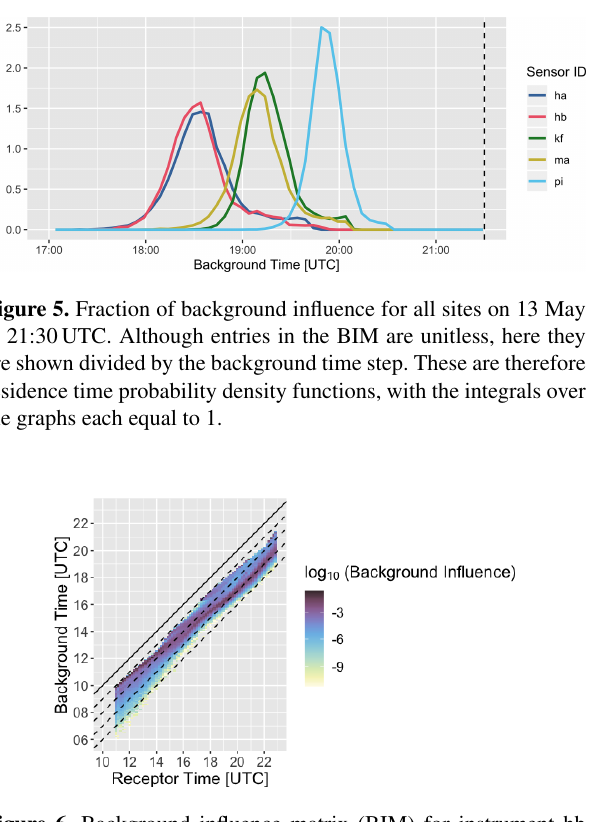
Figure 6. Background influence matrix (BIM) for instrument hb for the 13 May measurement day. The solid line is one-to-one and represents a residence time of 0h within the modeling domain. The dashed lines represent residence times of 1, 2, 3, and 4h within the modeling